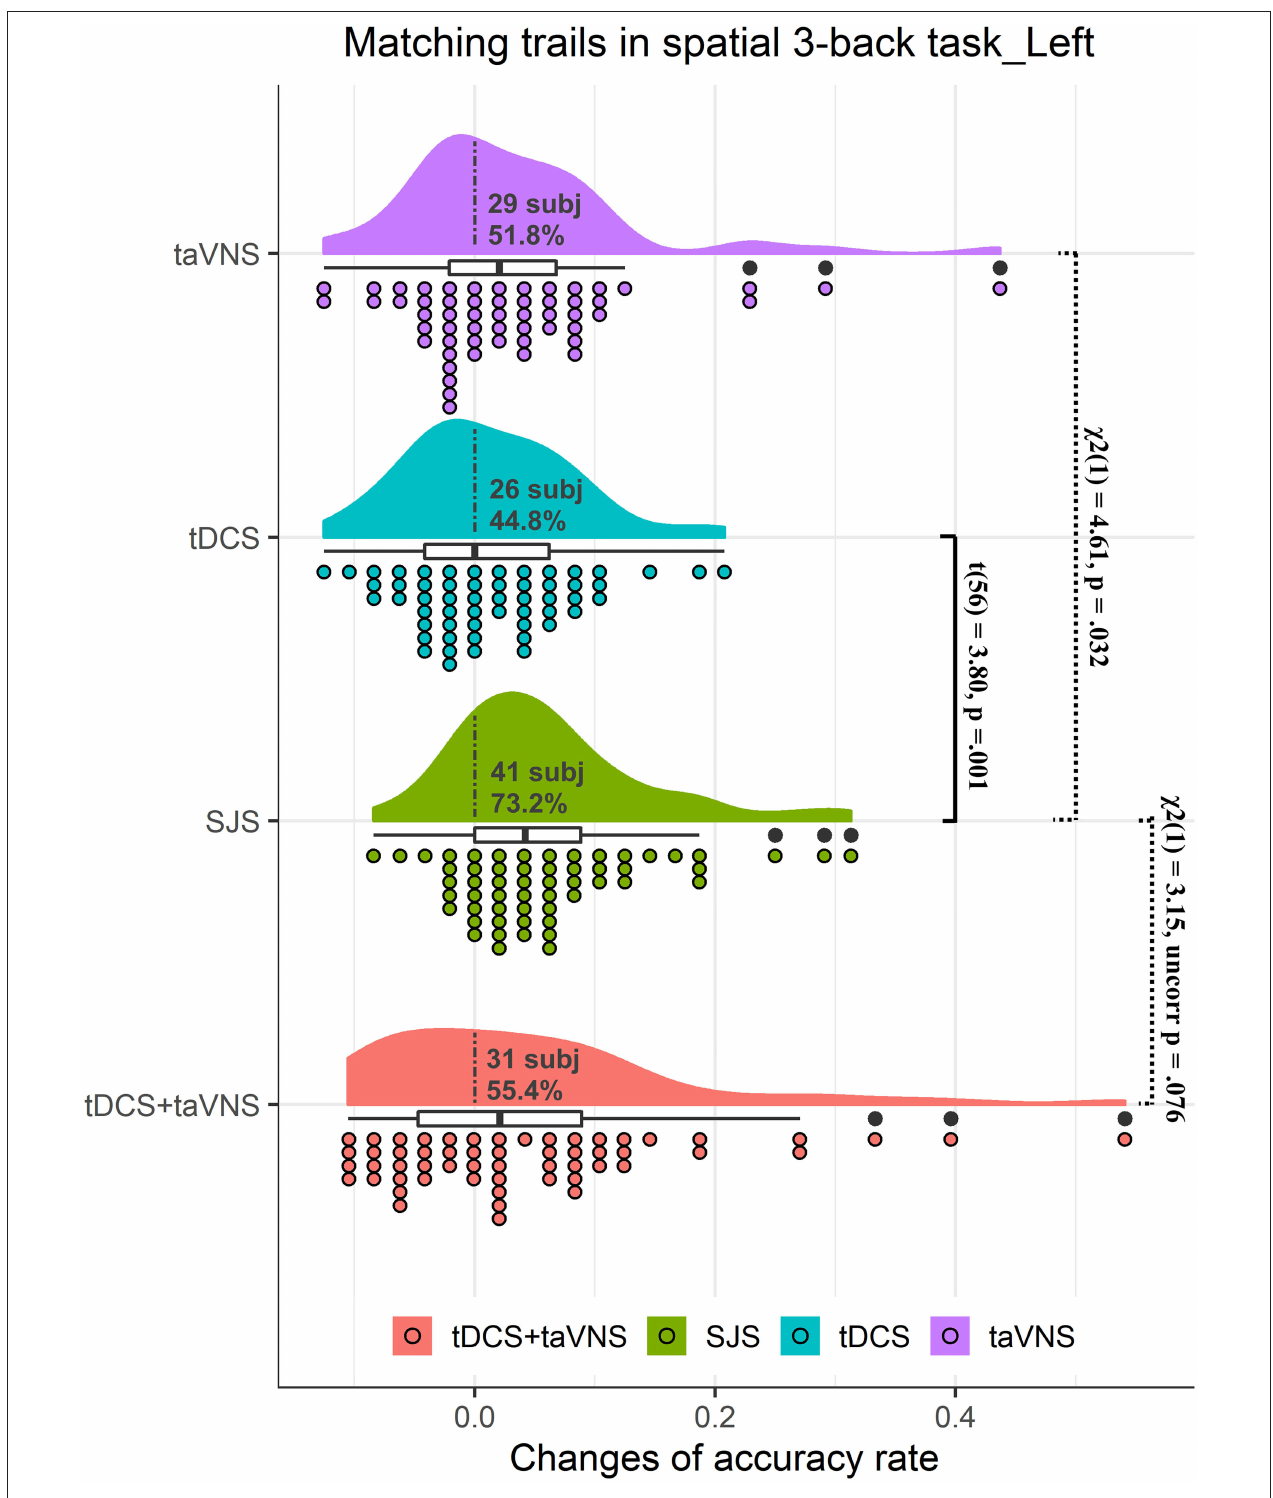
FIGURE 2 | Rain cloud plots of accuracy rate in matching trials (mACC) of the spatial 3-back task in experiment 1. Clouds and box plots represent the distribution of 1 -scores between the post-test and pre-test in taVNS, tDCS, SJS-L (simultaneous joint simulation of tDCS and taVNS), and tDCS + taVNS (the numerical summation effects of tDCS and taVNS) groups. Plots represent the 1 -score of each participant in the four conditions. Dotted lines separate positive change data with negative change data, and the number and proportion of subjects with improvements are presented in the clouds. The significant difference between tDCS and SJS-L groups and the improvement proportion difference between SJS-L and taVNS and tDCS + taVNS are presented in the figure.